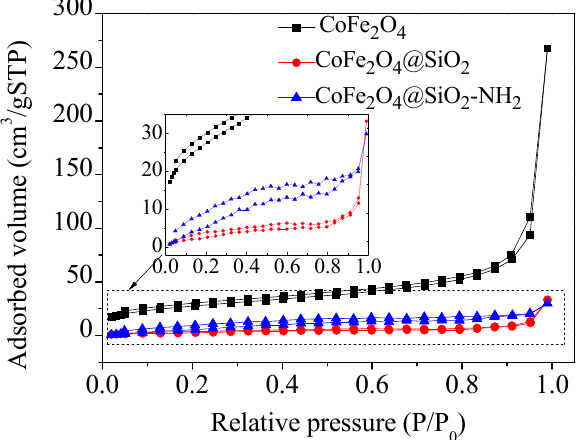
Figure 6. N 2 adsorption-desorption isotherms of materials.